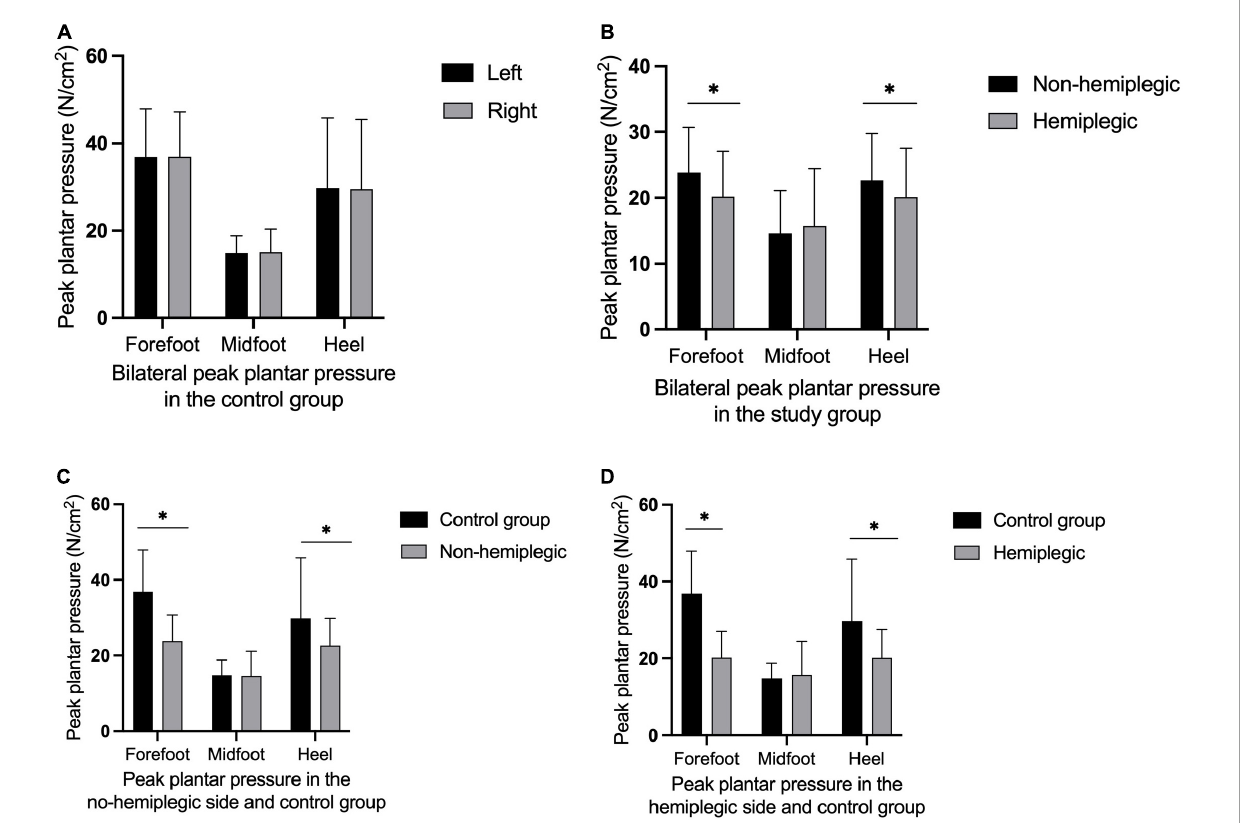
FIGURE1 Peak plantar pressure in both group. There was no significant difference in bilateral peak plantar pressure in the control group (A) ( P > 0.05). The peak plantar pressure of the forefoot and heel on the non-hemiplegic side were significantly higher than in the hemiplegic side in the study group (B) ( P < 0.001). The peak plantar pressure of the forefoot and heel on the non-hemiplegic side of the study group was significantly lower than that in the control group (C) ( P < 0.05). The peak plantar pressure of the forefoot and heel on the hemiplegic side of the study group was significantly lower than that in the control group (D) ( P < 0.05). ∗ Indicates significantly